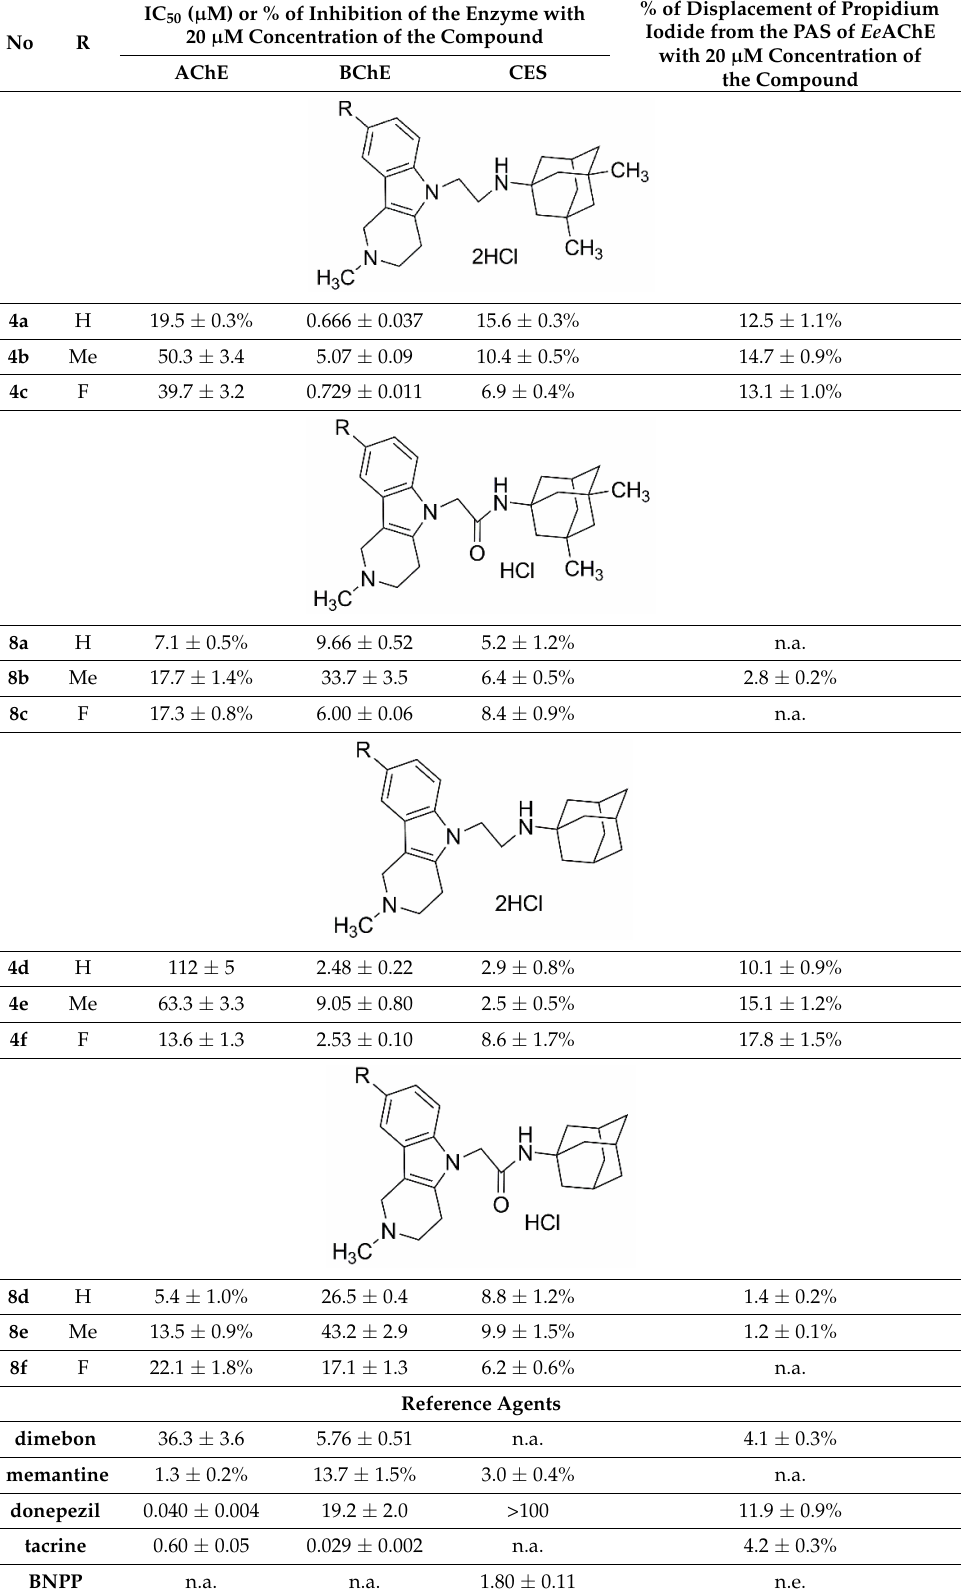
Table 2. Esterase profiles of aminoadamantane– γ -carboline conjugates and their ability to displace propidium iodide from the AChE